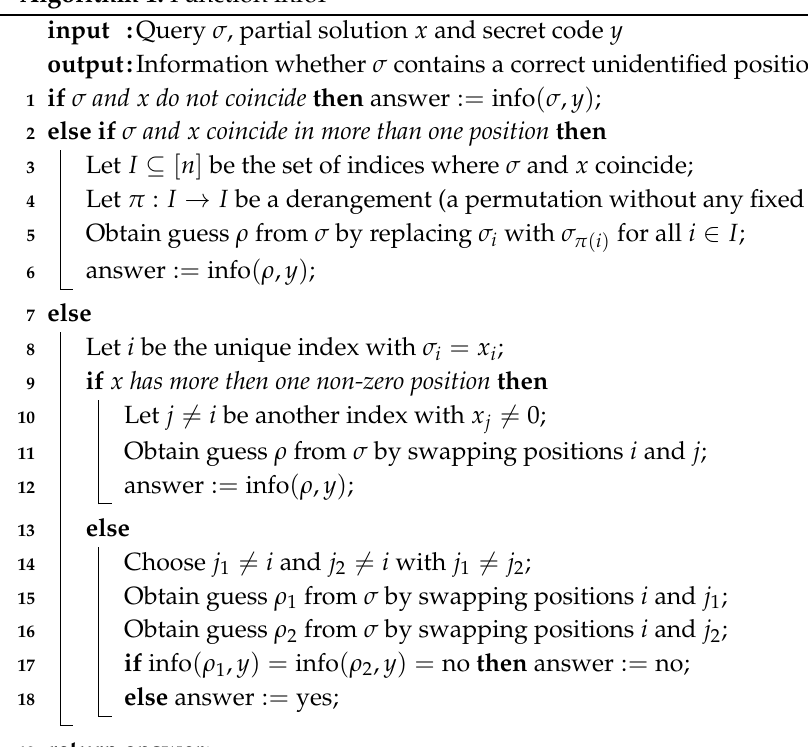
Algorithm 1: Function infoP